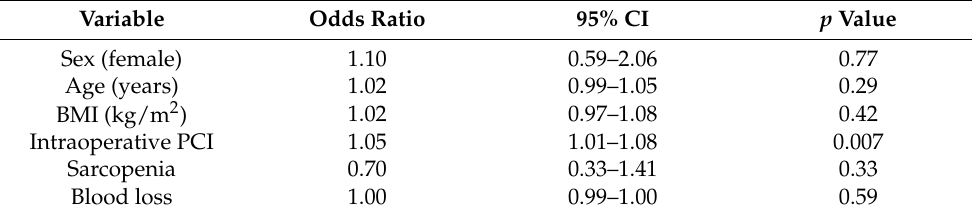
Table 3. Multivariate Regression Evaluating 90-day Severe